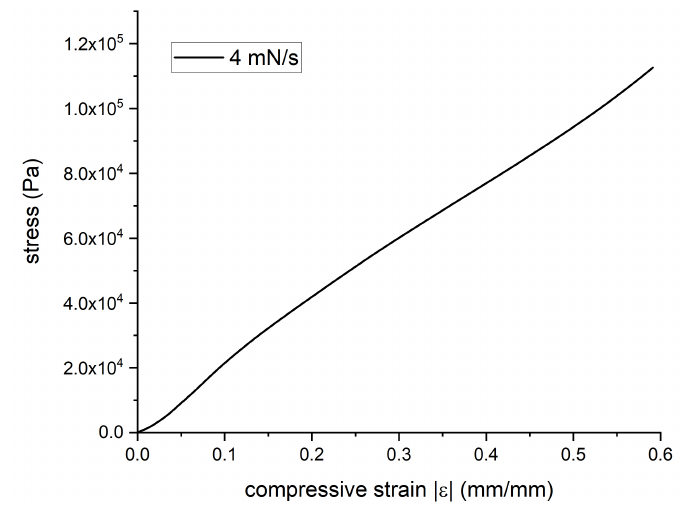
Figure 5. Stress versus strain curve in compression.